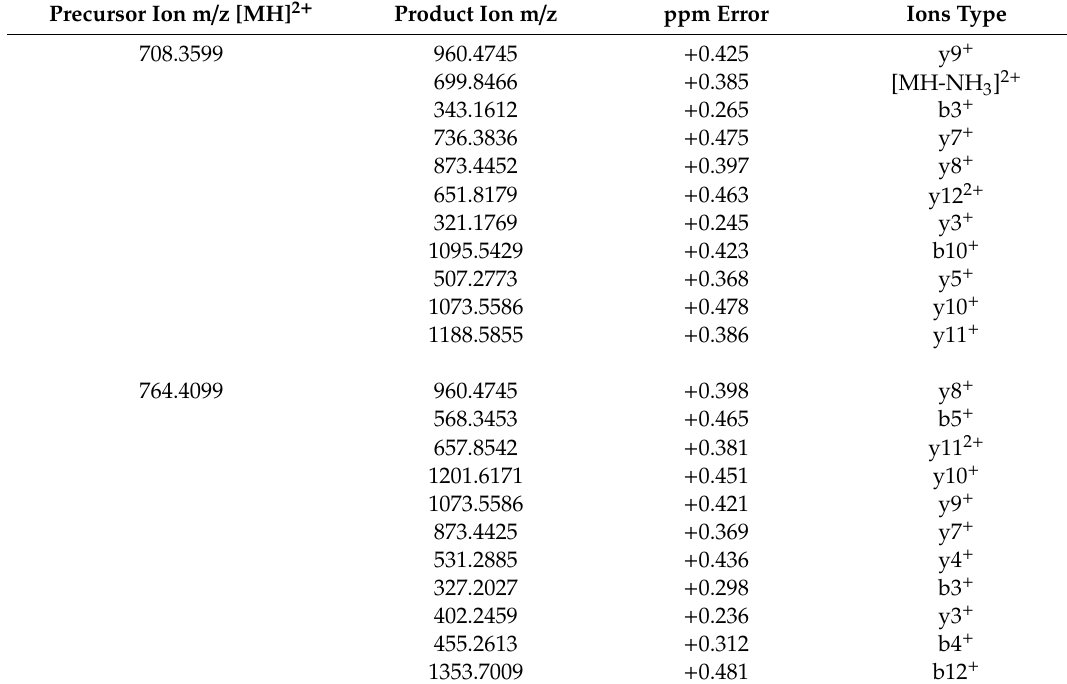
Table 4. Precursor protonated ions m / z of selected peptides and monoisotopic mass of the product CID ions. As expected, y and b ions were the only formed with CID